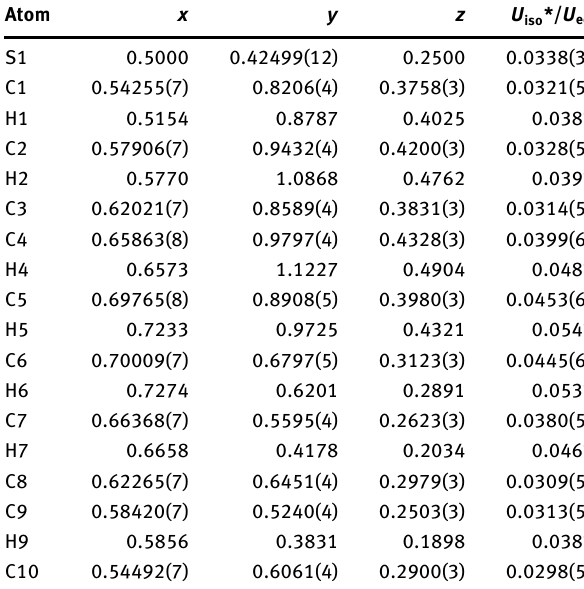
Table 2: Fractional atomic coordinates and isotropic or equivalent isotropic displacement parameters (Å 2